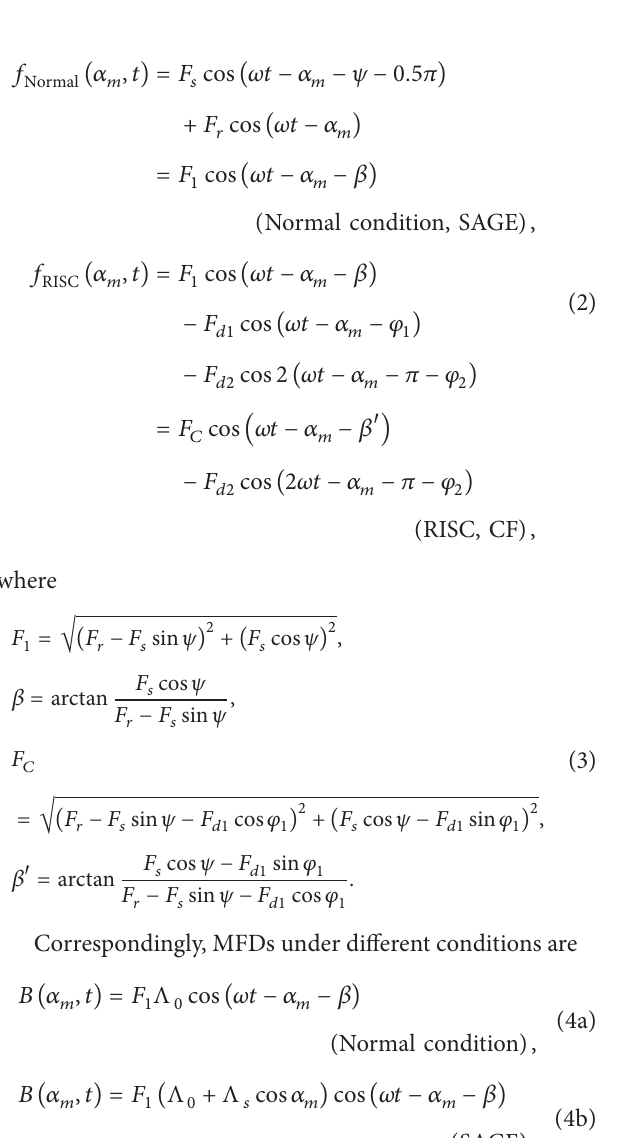
Figure 2: Structure and magnetic force of stator